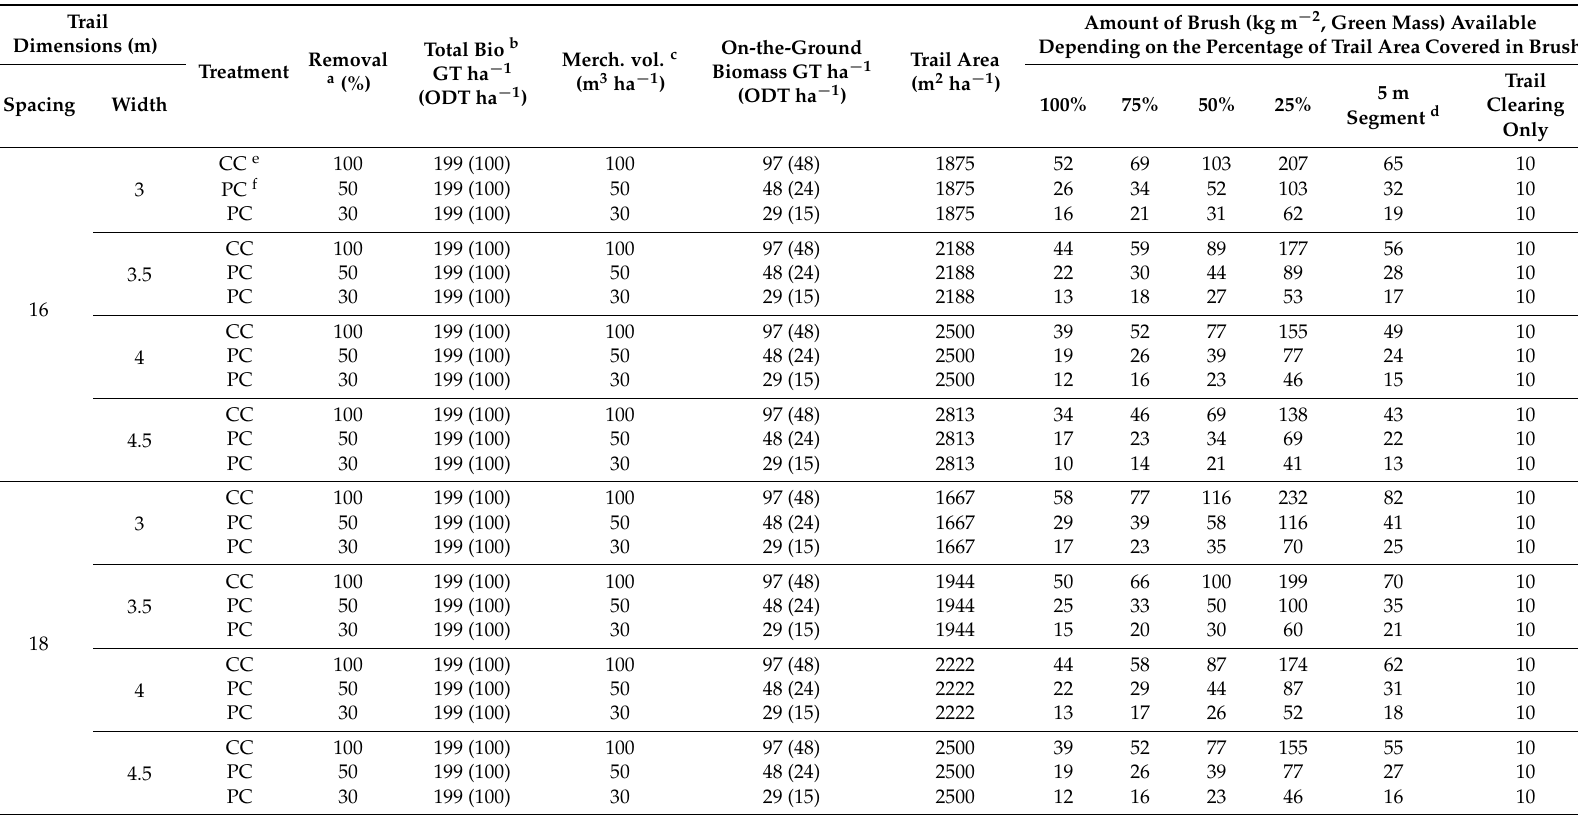
Table A5. Amount of brush available for soil protection as brush mats depending on trail spacing, trail width and varying trail coverage obtained from a naturally regenerated deciduous stand